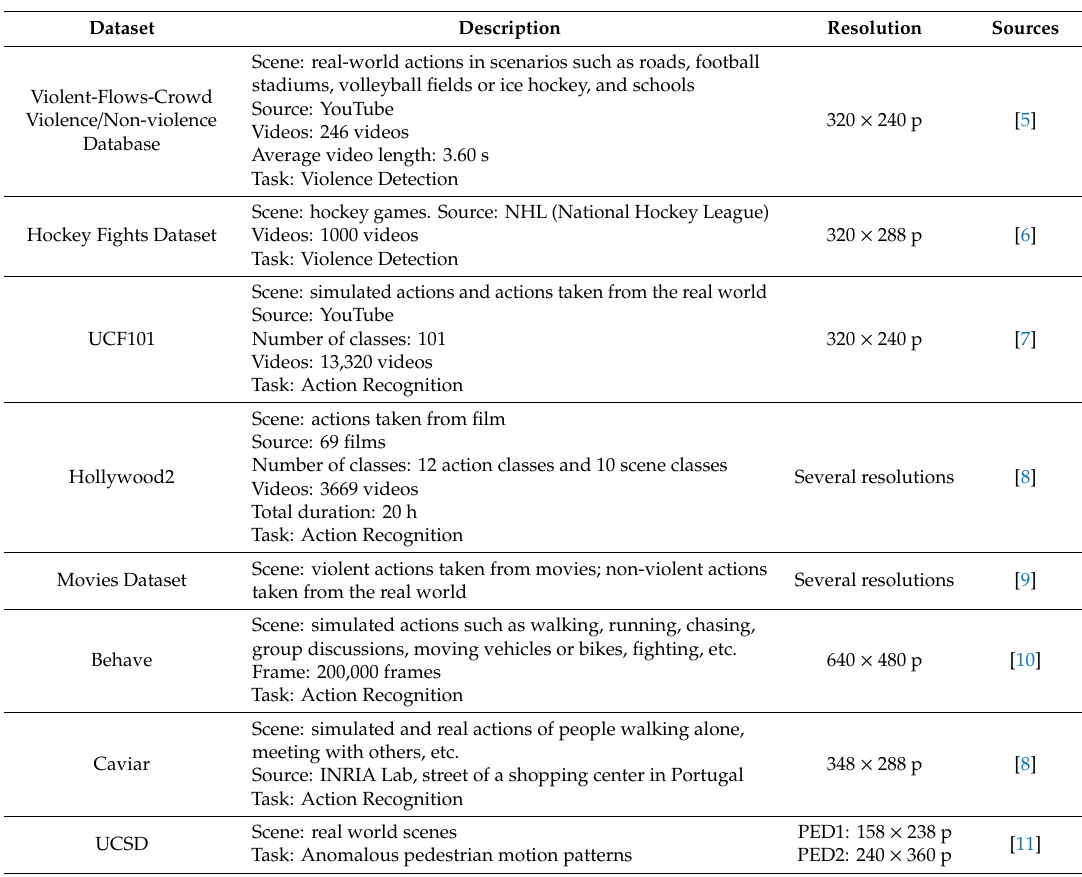
Table 1. Dataset Summary